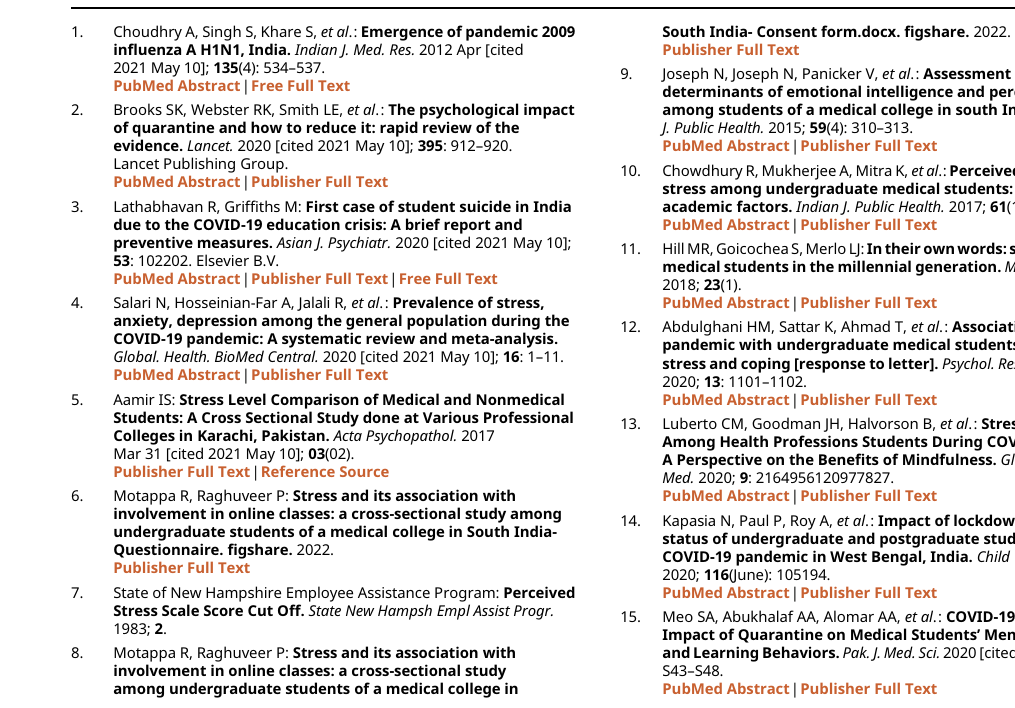
Figshare: Stress and its association with involvement in online classes: a cross-sectional study among undergraduate students of a medical college in South India. https://doi.org/10.6084/m9.figshare.19375205.v1. 17 This project contains the following underlying data: (cid:129) Appraisal of stress V2.xlsx (This is the study participants data in the form of an excel sheet)